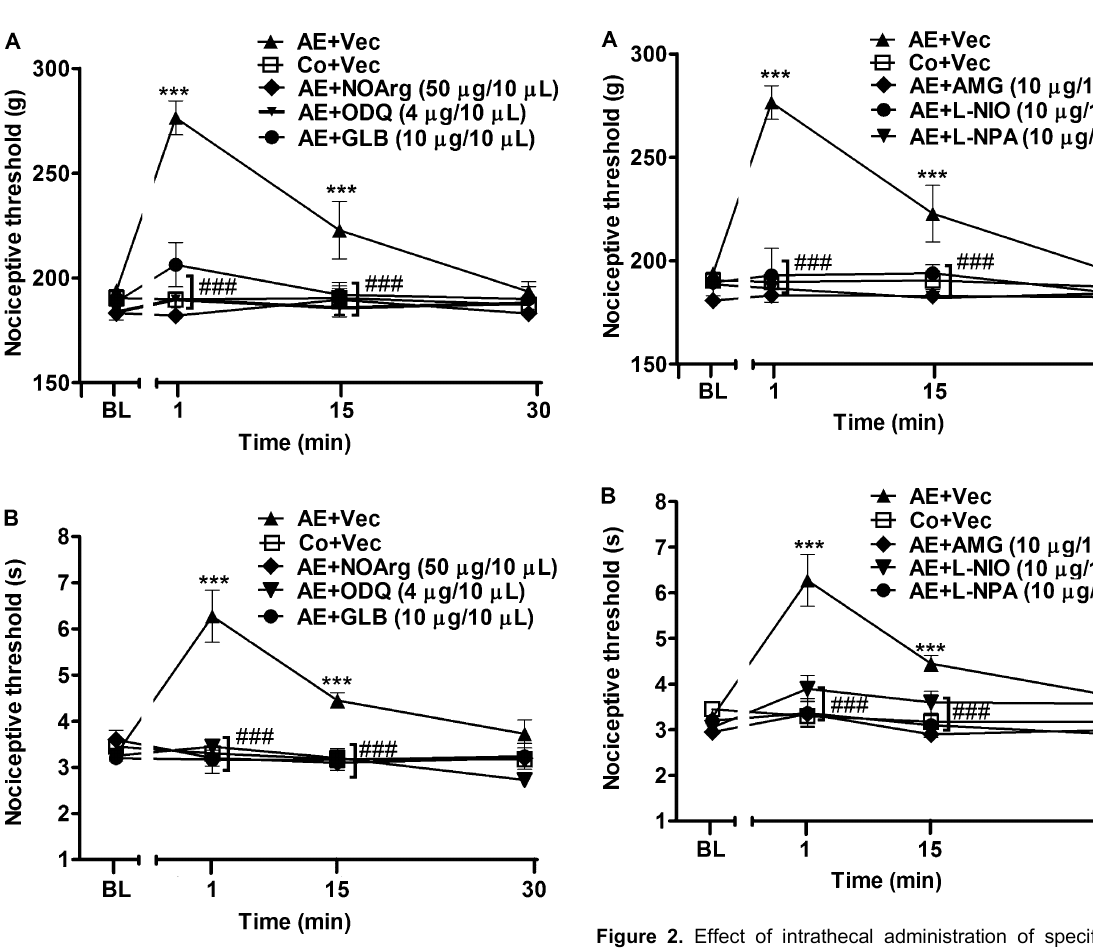
Figure 1. Effect of intrathecal administration of nitric oxide/ cGMP/K ATP pathway inhibitors on the antinociception induced by acute aerobic exercise (AE) in the paw-withdrawal ( A ) and tail- flick ( B ) tests. Rats were pretreated with intrathecal injection of N -nitro-L-arginine (L-NOArg, 50 m g/10 m L), 1H-(1,2,4)oxidia- zolo[4,3-a]quinoxalin-1-one (ODQ, 4 m g/10 m L), and glibencla- mide (GLB, 10 m g/10 m L) immediately before the onset of AE, which lasted for a mean of 45.3±2.0 min. Mechanical and thermal nociceptive thresholds were measured before and after 1, 15, 30 min of AE. Data are reported as means±SE of 6 animals per group. ***P , 0.001, compared to the control group (Co); ### P , 0.001, compared to the AE group (one-way ANOVA followed by the Bonferroni test). Vec: vehicle; BL: baseline